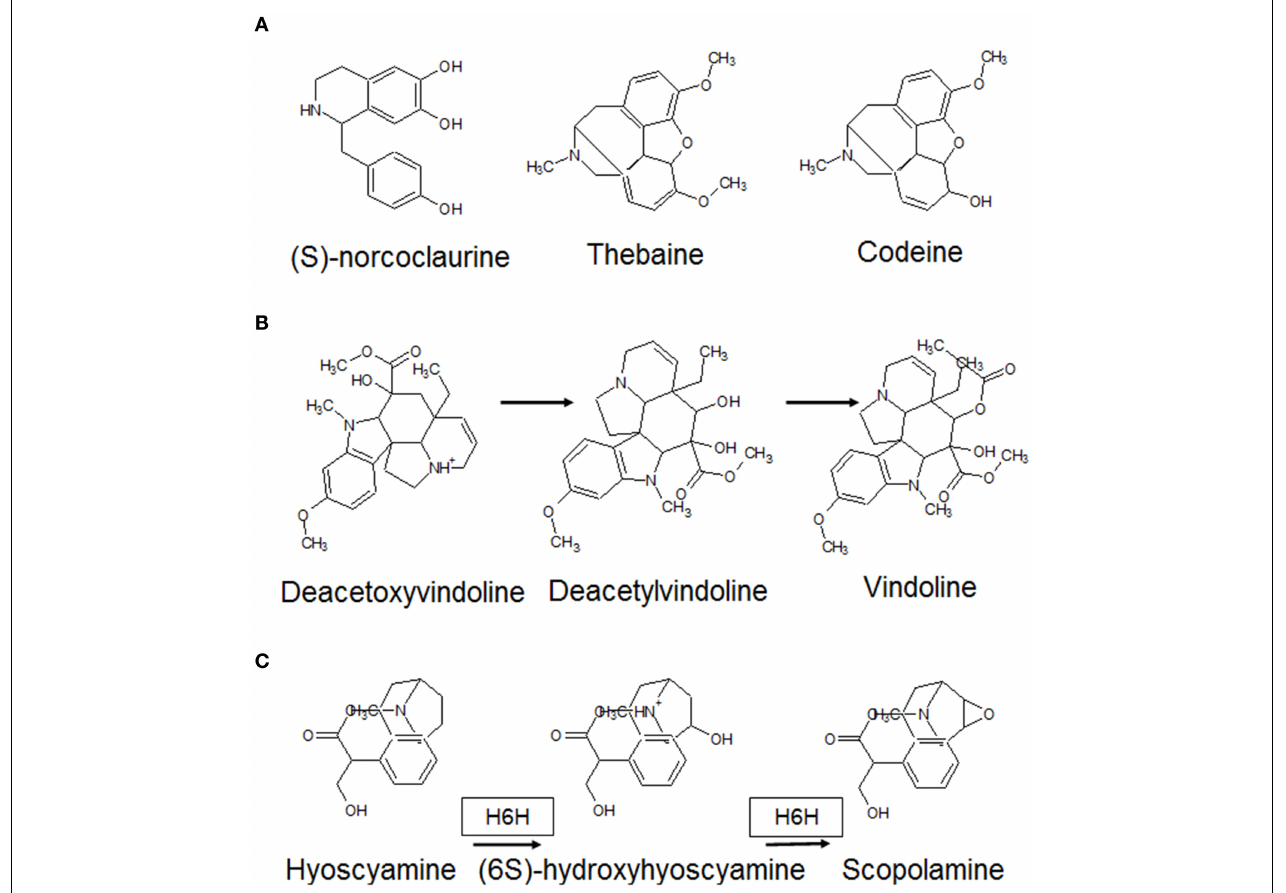
FIGURE 8 | Alkaloid classes that require 2-oxoglutarate as a co-substrate. These N-heterocyclic molecules are often synthesized in preparation for growth of new tissue and serve as an on-demand nitrogen source accessible at all times. As the tissues grow and differentiate, alkaloid reserves have been shown to progressively deplete. (A) (S)-norcoclaurine is the precursor of the isoquinoline classs of alkaloids (codeine, thebaine).